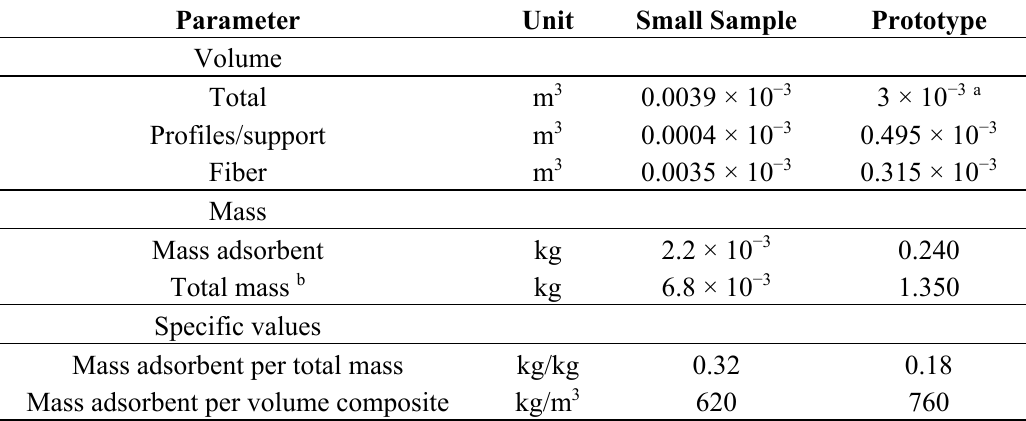
Table 2. Main parameters of small sample and